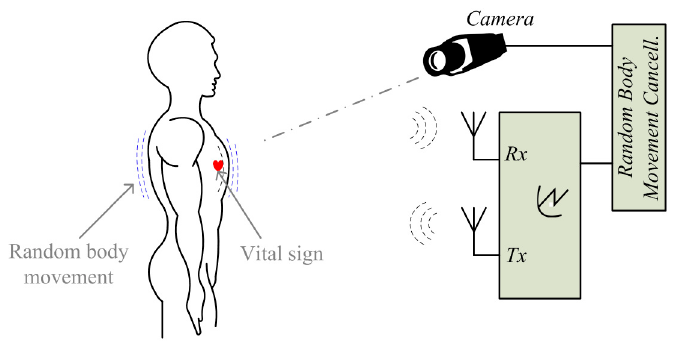
Figure 7. Setup of radar sensing with random body movement using a radar-camera hybrid system.